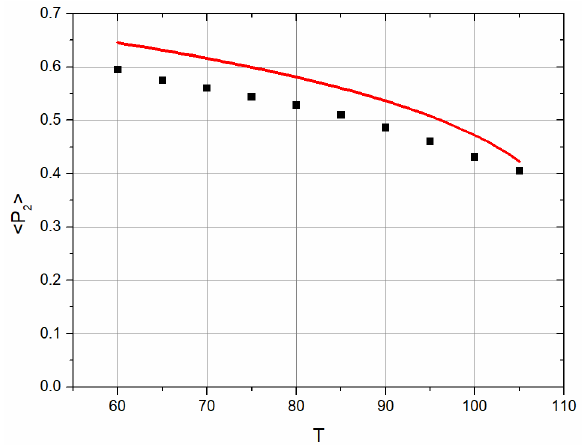
Figure 7. Orientational order parameter < P 2 > as a function of temperature T : data obtained by fitting the azimuthal intensity profile of the WA XRD reflection (black squares) and Maier-Saupe theoretical prediction (red line). For the latter, we used the approximate expression < P 2 > = ( 1 − 0.98 T / T NI ) 0.22 , with T NI indicating the clearing point.